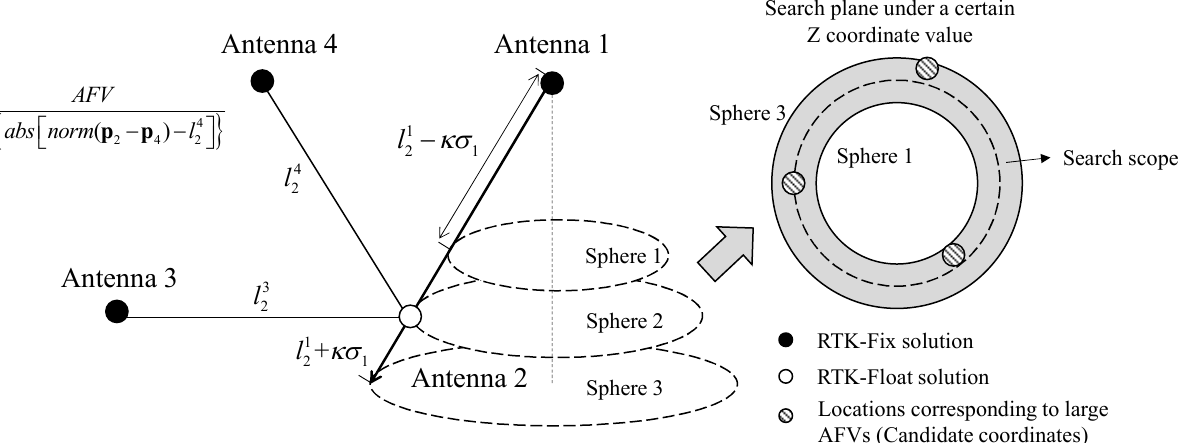
Figure 2. Schematic diagram of BCAFM. In Figure 2, the position of antenna 2 only obtained RTK float solutions.